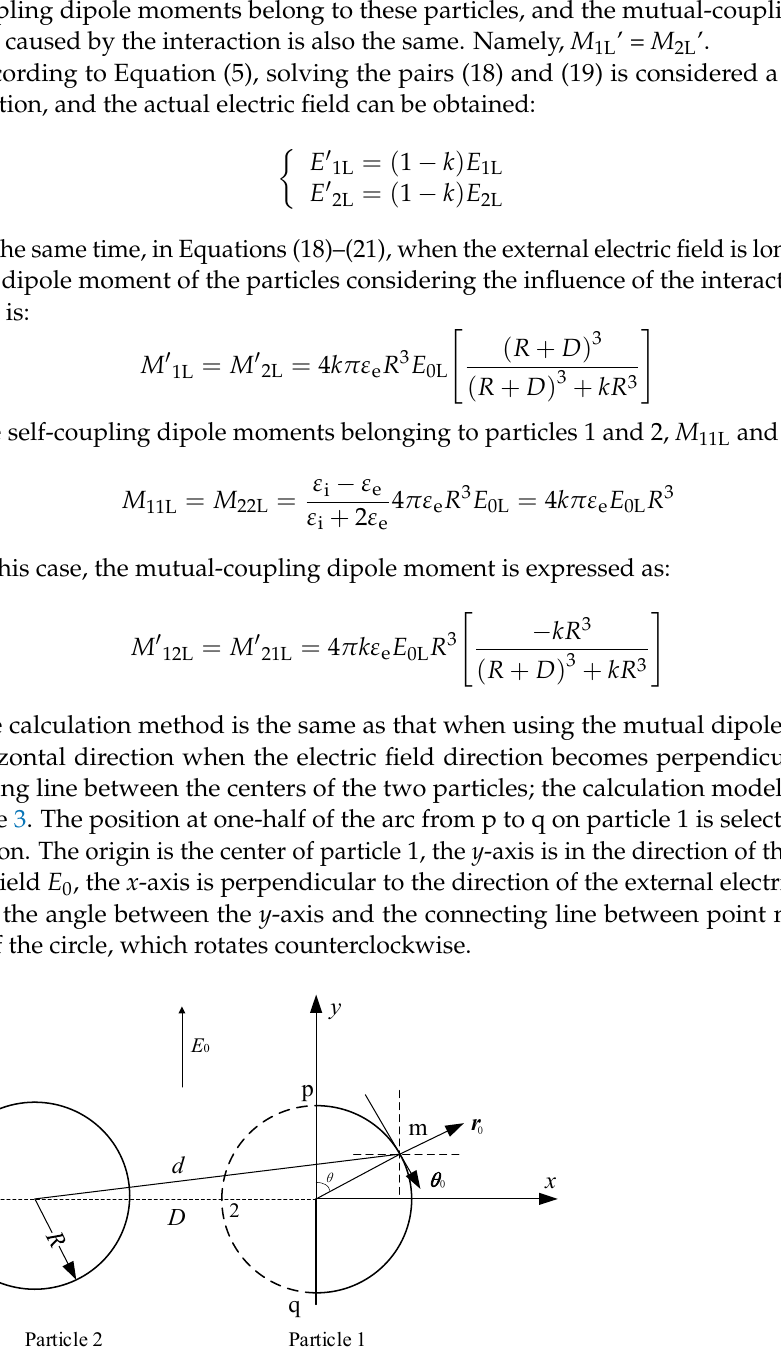
Figure 3. The calculation model for the two ‐ particle system in the longitudinal external electric field.